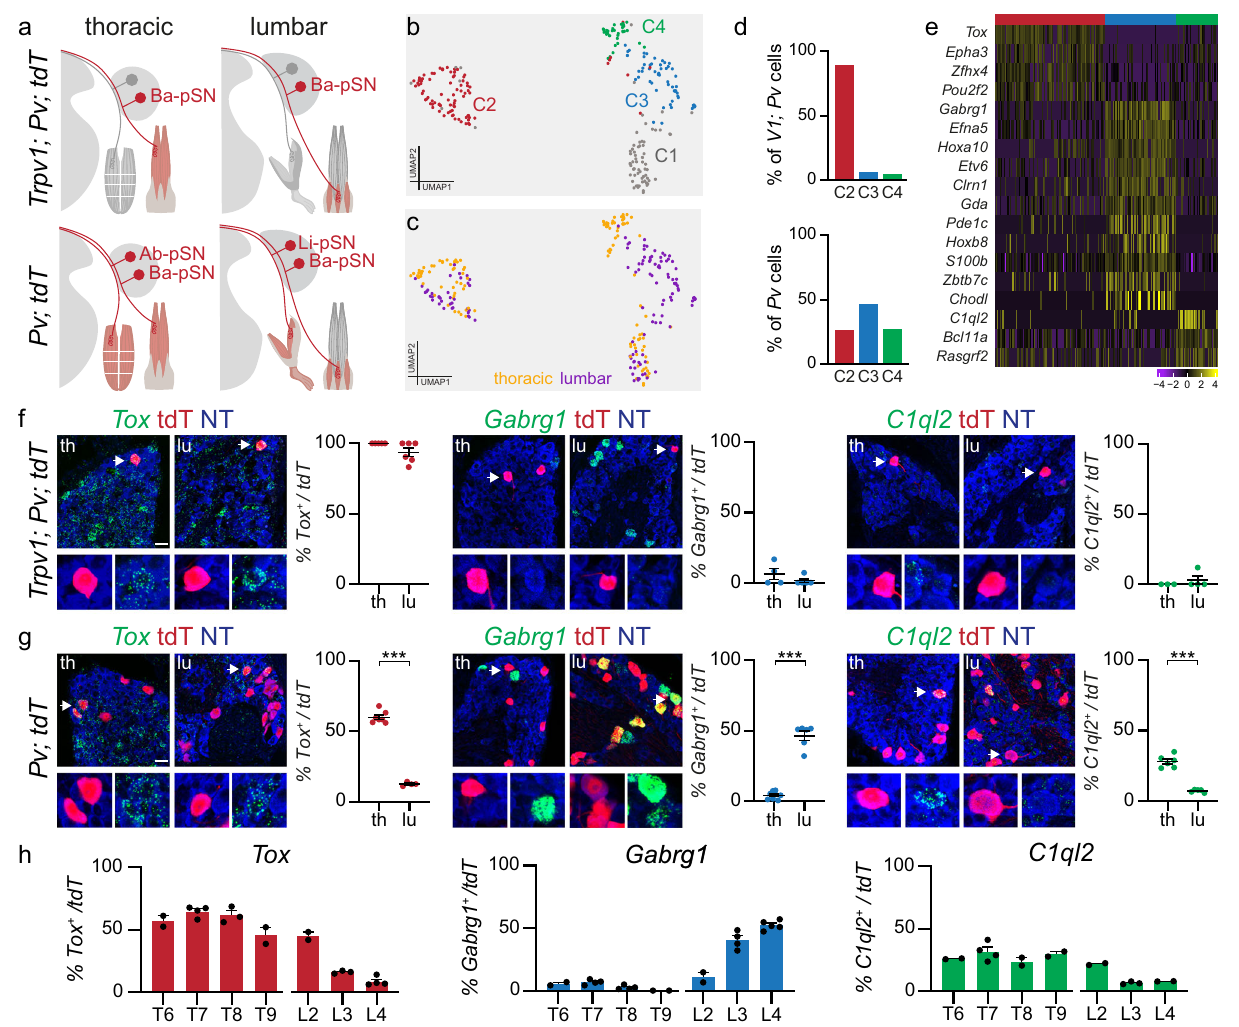
Fig. 3 | Molecular pro fi les of back-, abdominal- and hindlimb-innervating proprioceptors. a Schematics illustrating labeling of the Ba-pSN subset captured in Trpv1 Cre ; Pv Flp ; Ai65 and all proprioceptors in Pv Cre ; Ai14 at thoracic and lumbar levels. b UMAP visualization of cell clusters after transcriptome analysis of tdTo- mato + DRG neurons from p1 Trpv1 Cre ; Pv Flp ; Ai65 and Pv Cre ; Ai14 mice at thoracic and lumbar levels. c UMAP visualization of cell clusters color-coded according to the anatomical origin (thoracic, yellow; lumbar, purple) of neurons. d Bar graph illus- trating the percentage of Trpv1 Cre ; Pv Flp ; Ai65 (top) and Pv Cre ; Ai14 (bottom) cells found in clusters C2 (red), C3 (blue), C4 (green). e Differential gene e xpression analysis (logcounts) for clusters C2 (red), C3 (blue), and C4 (green).